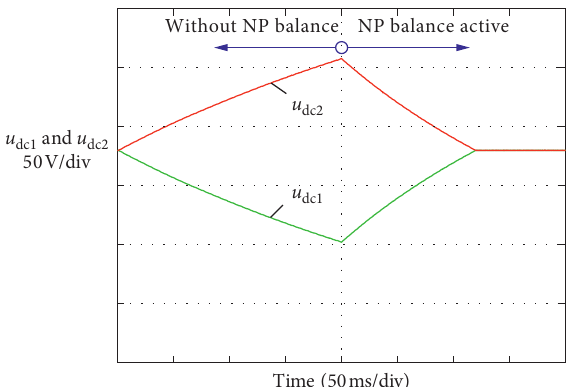
Figure 11: Simulation results of DC-link voltage with and without NP balance